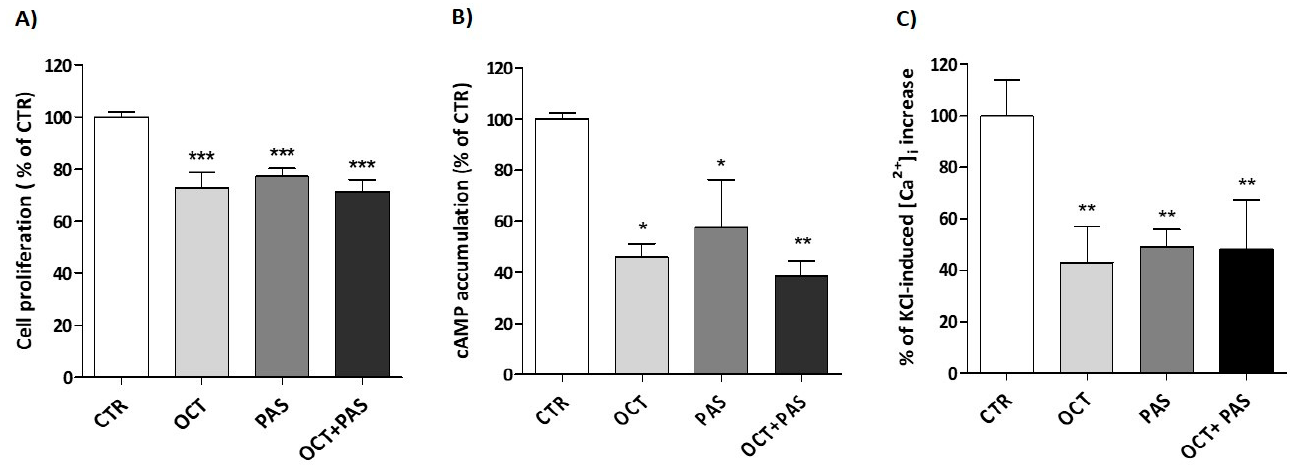
Figure 4. Effect of OCT (10 − 8 M) and PAS (10 − 8 M), alone or in equimolar combination, on cell proliferation, intracellular cAMP and [Ca 2+ ] i levels in GH4C1 cells. Panel ( A )) Antiproliferative effect of SRLs in GH4C1 cell line. Data are expressed as mean ± SEM of four different experiments, performed in triplicate, and reported as percent inhibition of control. Panel ( B )) Inhibitory effect of OCT, PAS and OCT+PAS on cAMP levels in IBMX-treated GH4C1 cells. Data are expressed as mean percent inhibition of untreated cells ± SEM of three different experiments performed in triplicate. Panel ( C )) Histograms represent the SRL-induced [Ca 2+ ] i decrease in KCl-stimulated cells as mean (%) ± SEM of five independent experiments. (CTR, control; OCT, octreotide; PAS, pasireotide; * p < 0.05, ** p < 0.01, *** p < 0.001 vs. control).